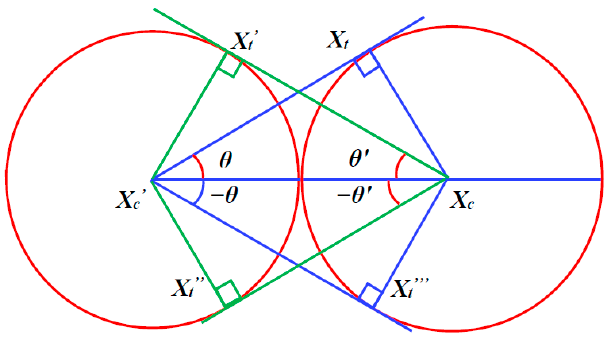
Figure 2. The exploration in the CSA.